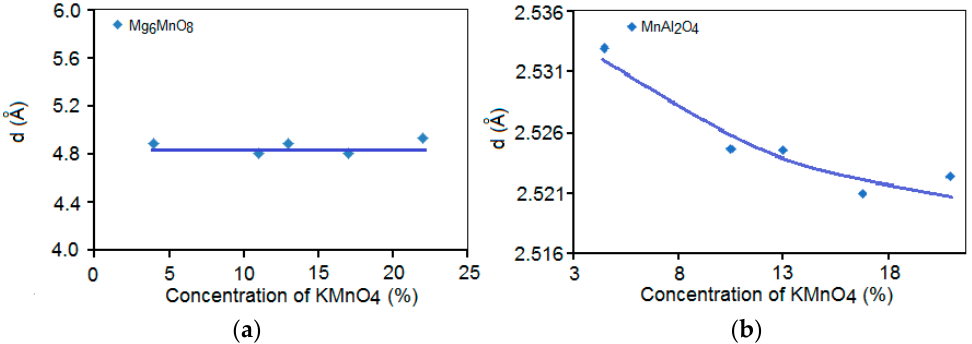
Figure 4. Influence of KMnO 4 concentration in the initial batch on Mn spinels formation.